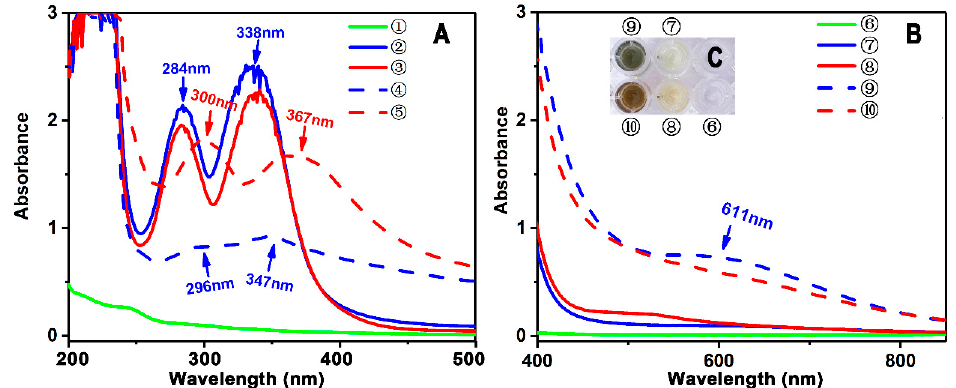
Figure 4. Experimental results of UV-vis spectra analysis of Fe 2+ -chelation with scutellarein and scutellarin. ( A ) Wavelength 200 – 500 nm; ( B ) wavelength 400 – 900 nm ( ① 0.90 mmol/L Fe 2+ ; ② 0.09 mmol/L scutellarin; ③ 0.09 mmol/L scutellarein; ④ reaction mixture of 0.90 mmol/L Fe 2+ with 0.09 mmol/L scutellarin; ⑤ reaction mixture of 0.90 mmol/L Fe 2+ with 0.09 mmol/L scutellarein.); ( ⑥ 7.00 mmol/L Fe 2+ ; ⑦ 0.70 mmol/L scutellarin; ⑧ 0.70 mmol/L scutellarein; ⑨ reaction mixture of 7.00 mmol/L Fe 2+ with 0.70 mmol/L scutellarin; ⑩ reaction mixture of 7.00 mmol/L Fe 2+ with 0.70 mmol/L scutellarein.); ( C ) appearance of the solutions.